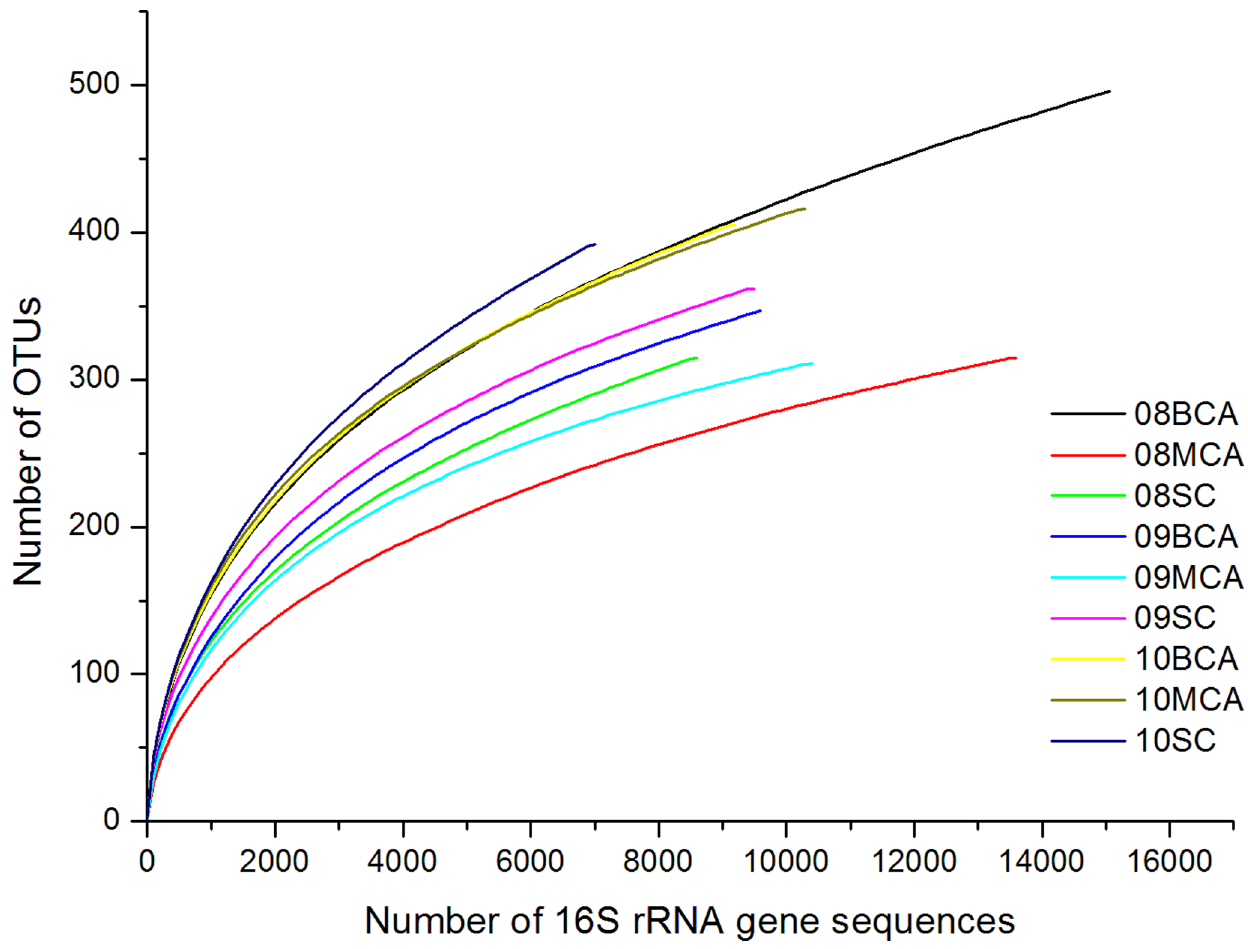
Figure 1. Rarefaction analysis of the 16S rRNA gene sequences among phycosphere samples using an evolutionary distance threshold of 3% (i.e., 97% similarity). doi:10.1371/journal.pone.0102879.g001 PLOS ONE |